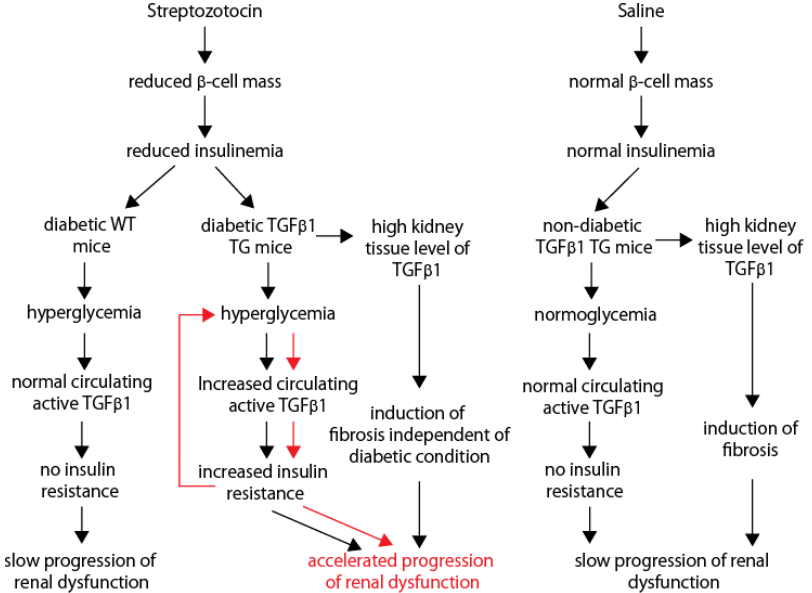
Figure 9. The vicious cycle of hyperglycemia, in which increased circulating active TGFβ1 and insulin resistance may explain the accelerated progression of renal dysfunction in diabetic TGFβ1 TG mice. Red arrows indicate the vicious cycle.